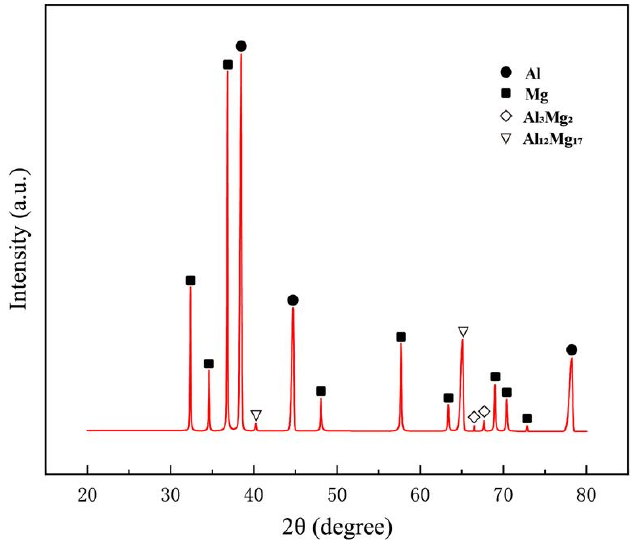
Figure 16. XRD results of the fracture surface.